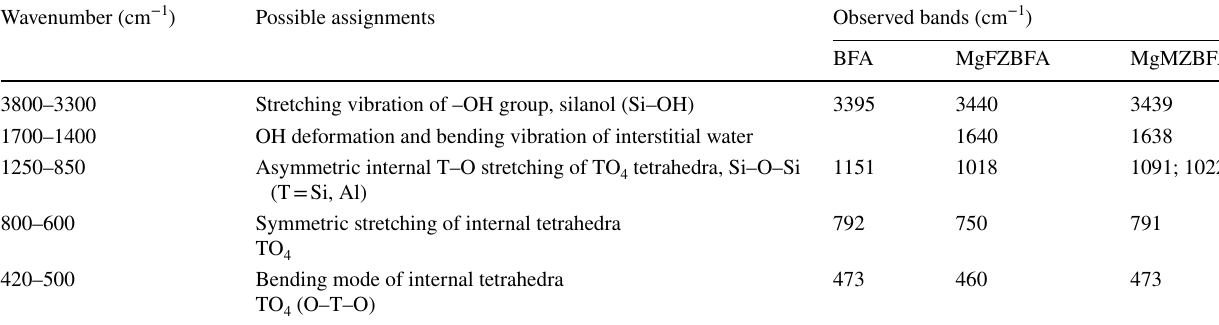
Table 2 FTIR characterization of BFA, MgFZBFA, and MgMZBFA showing different infrared absorption bands Wavenumber (cm −1 ) Possible